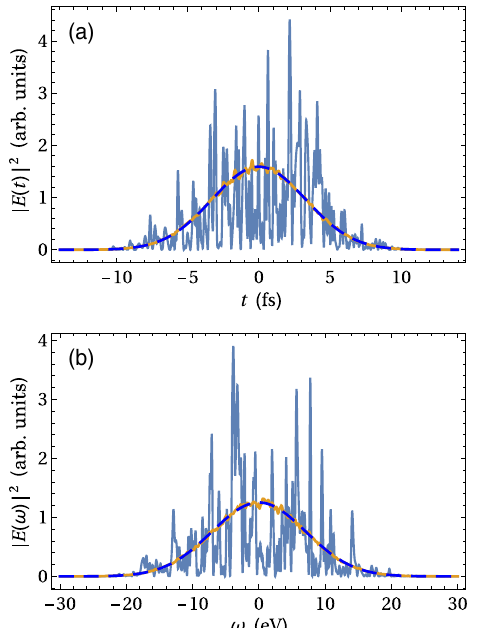
FIG. 2. Intensity profiles of a stochastic UDSP pulse with a ¼ π , Λ (a) temporal and (b) spectral intensity profiles are shown. The blue continuous curves display one realization of the stochastic pulse from Eqs. (1) and (4). The yellow continuous curves exhibit the ˜ E mean profiles of j E ð t Þj 2 and j ð ω Þj 2 , obtained by averaging over 1000 independent realizations. The blue dashed curves show the average intensities calculated from Eqs. (9) and